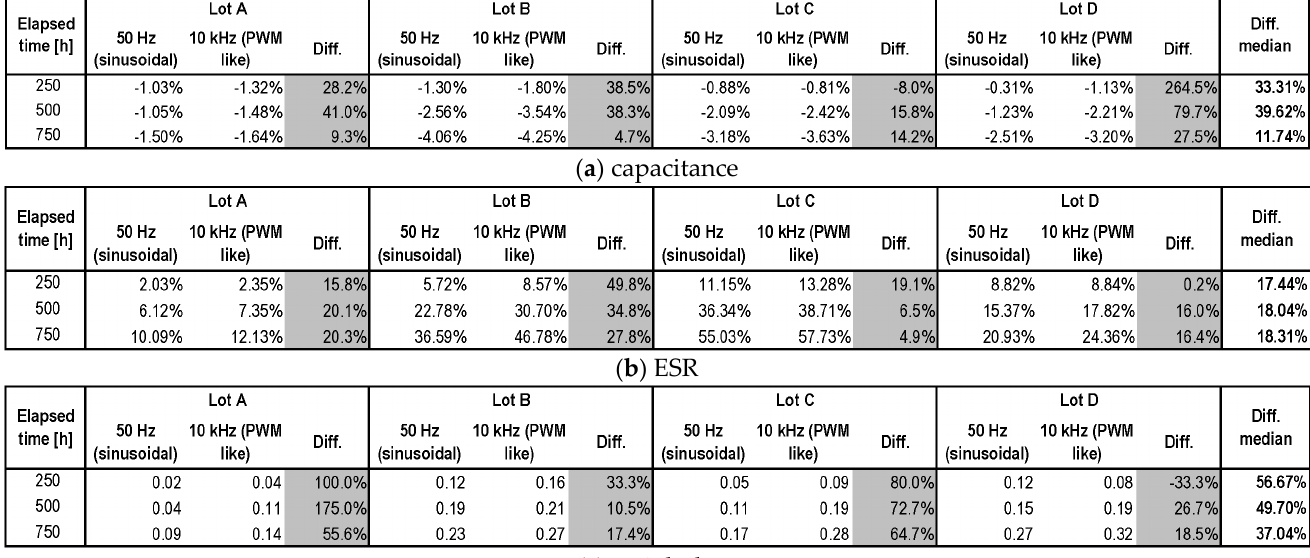
Figure 2. Aluminum electrolytic capacitors: aging of ( a ) capacitance, ( b ) ESR, and ( c ) weight loss (expressed in grams) vs. ripple frequency and elapsed time (peak–peak ripple amplitude 10%) [89].